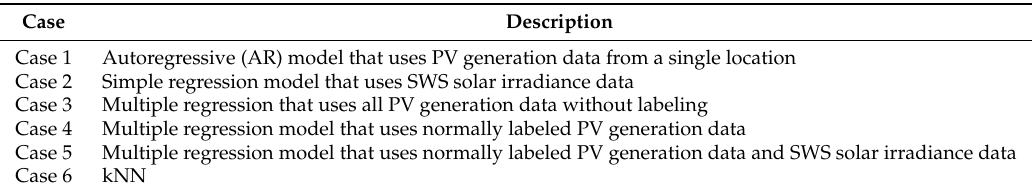
Table 3. Imputation case